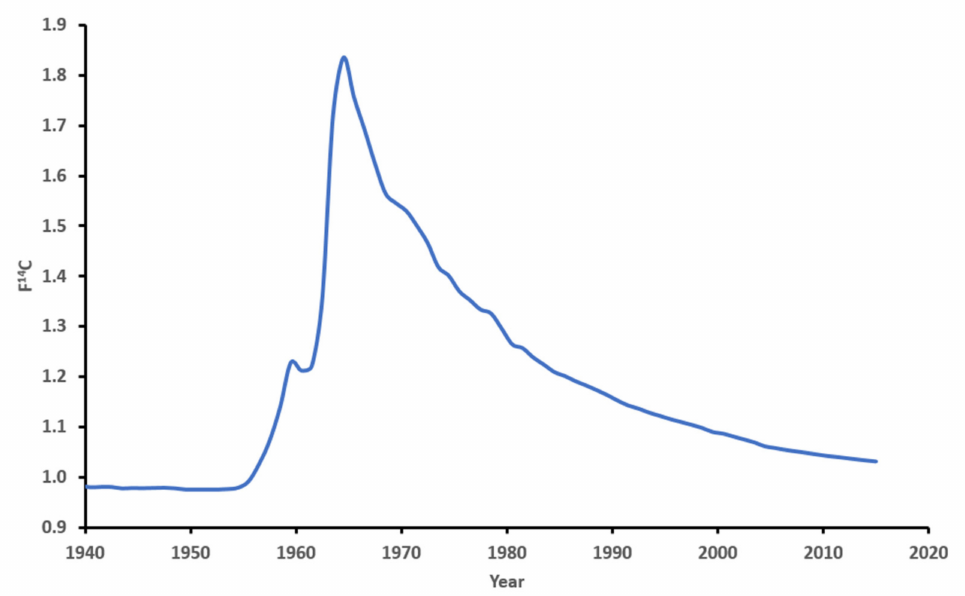
Figure 1. Average annual atomspheric 14 CO 2 records for Northen